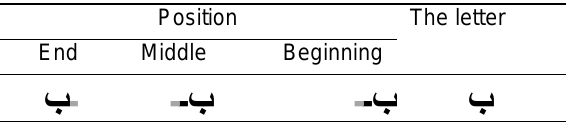
The letter Position